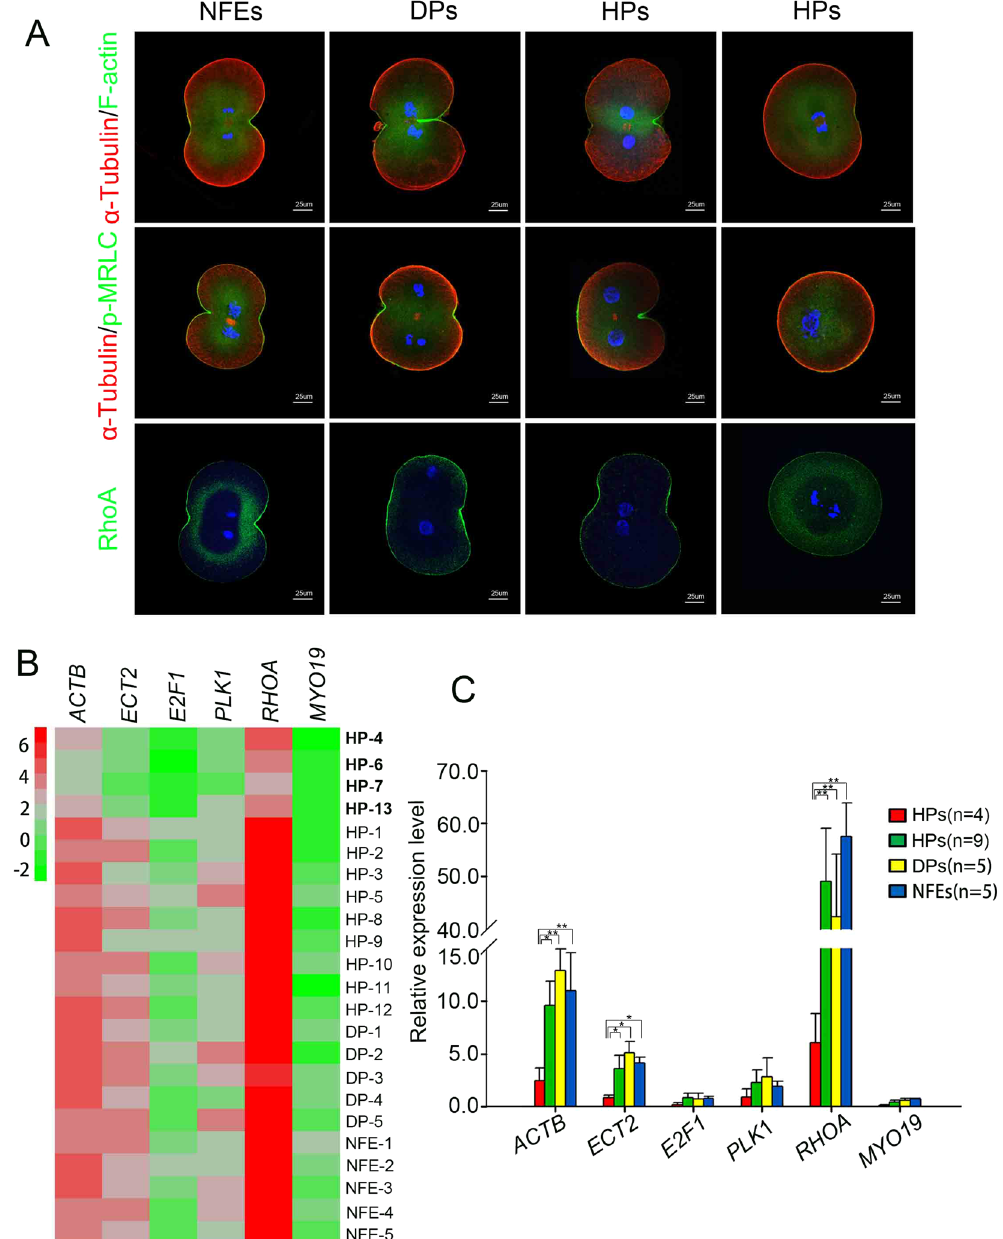
Figure 6. Self-diploidization of HPs might be result from a defect in Rho pathway activation. ( A ) Immunostaining of NFEs, DPs, and HPs at the first division stage, using antibodies against F-actin, p-MRLC, RhoA, and α -Tubulin; ( B ) Heatmap showing the relative expressions of the six core components of the Rho pathway detected by quantitative RT-PCR; ( C ) Quantitative RT-PCR analysis of the expression levels of the Rho pathway genes. An asterisk indicates a significant difference by a t-test (P < 0.05). NFEs: normal fertilized embryos, DPs: diploid parthenotes, HPs: haploid parthenotes, p-MRLC: serine19-phosphorylated myosin regulated light